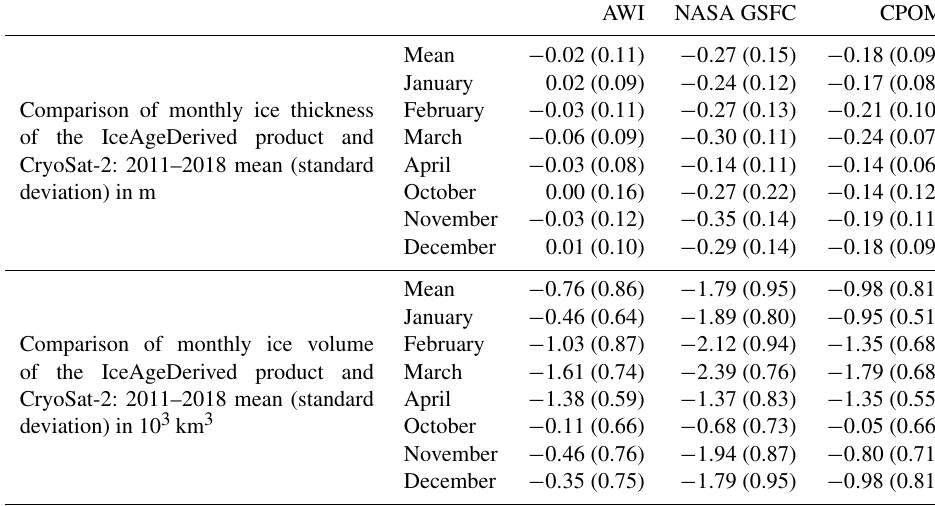
AWI NASA GSFC CPOM